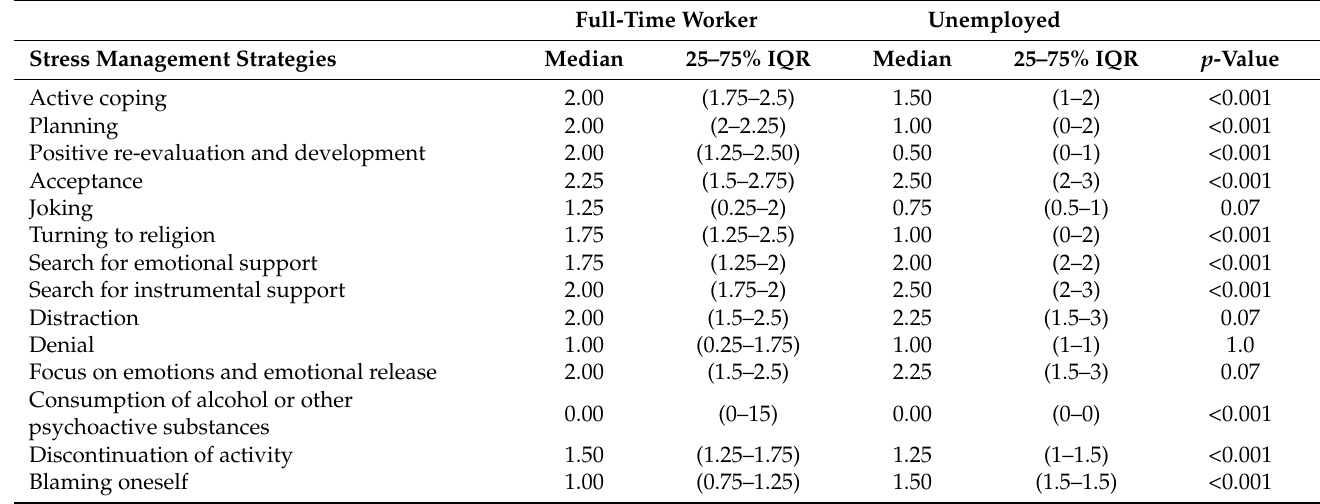
Table 6. Stress management strategies according to